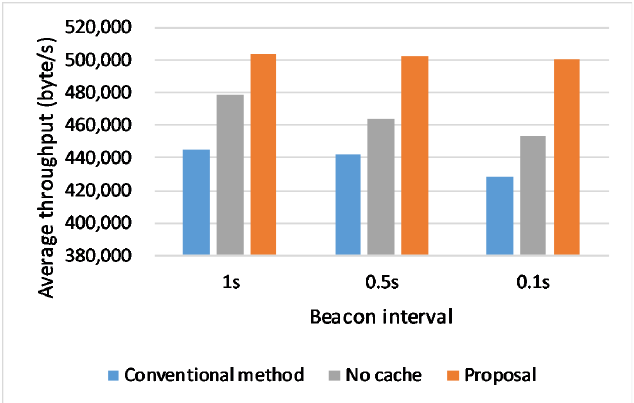
Figure 12. Throughput in different Beacon intervals.